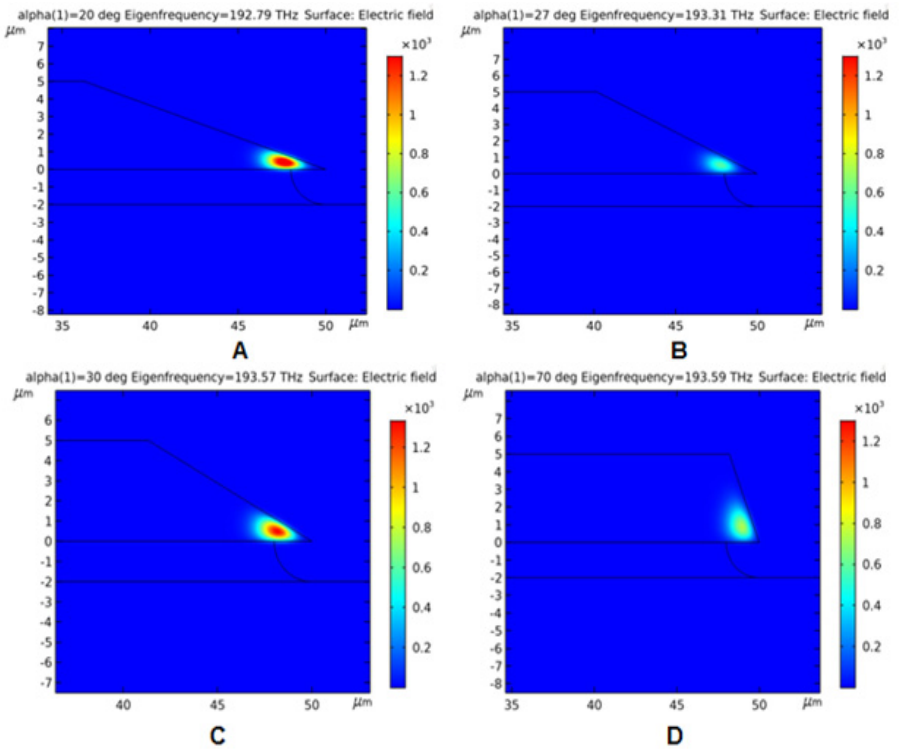
Figure 2. Finite Element Modeling Results at a wavelength of λ 0 = 1.55 µ m, natural resonator frequency F0 ~ 193 THz;: ( A )—wedge angle of 20 ◦ , the maximum value of the field is 1498 V / m; ( B )—wedge angle 27 ◦ , maximum field value − 580 V / m; ( C )—wedge angle 30 ◦ , maximum field value − 1398 V / m; ( D )—wedge angle 70 ◦ , maximum field value − 725 V / m. The scale on the right displays the distribution of the mode field strength.